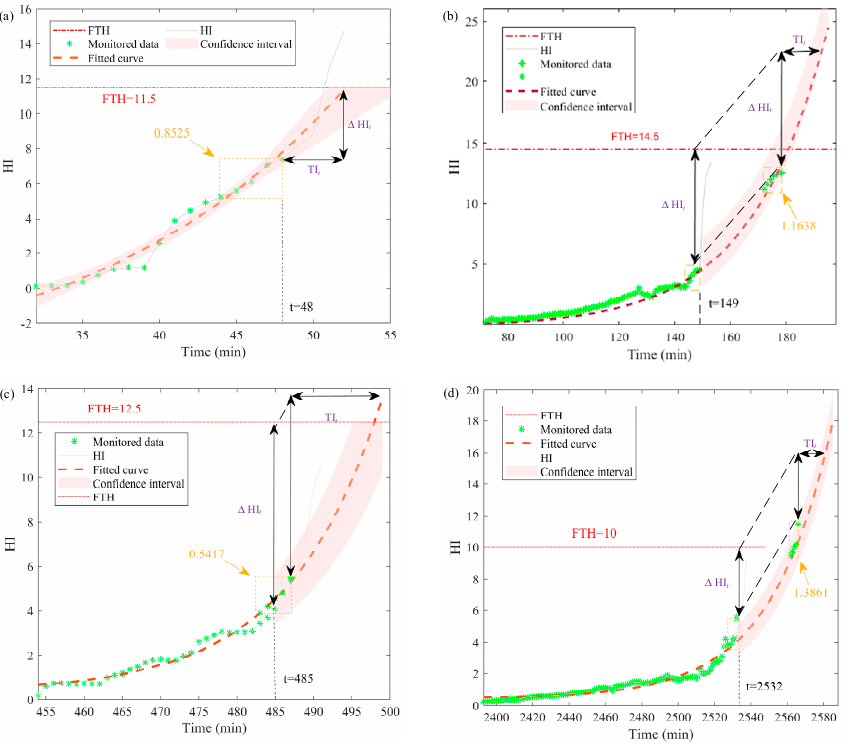
Figure 6. Degradation predictions of ( a ) bearing 1_5, ( b ) bearing 1_3, ( c ) bearing 2_1, and ( d ) bear- ing 3_1.